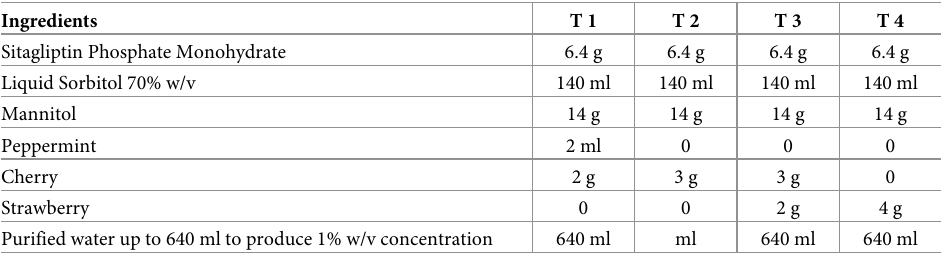
Table 1. Formulation of SiP oral